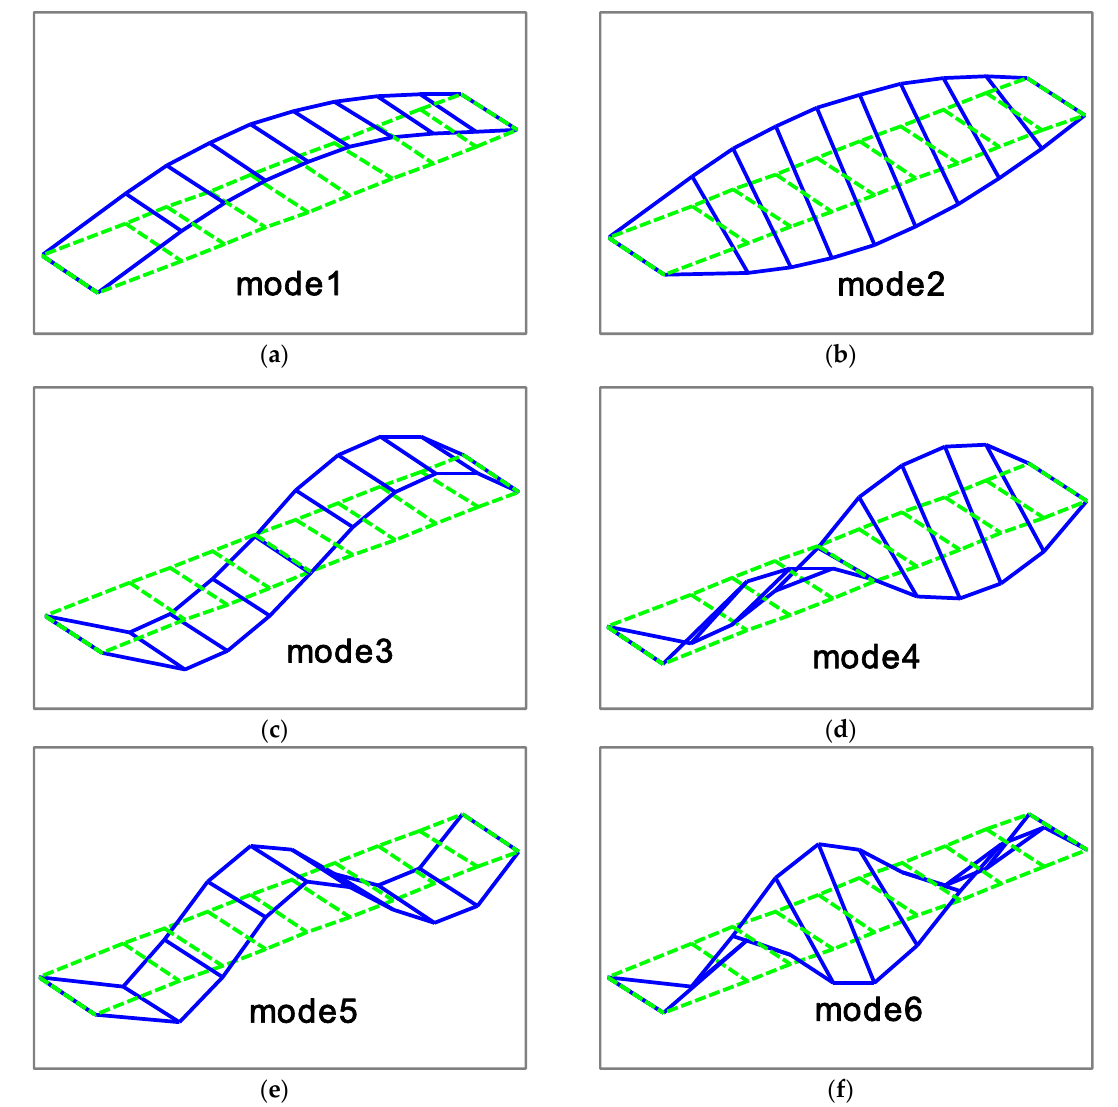
Figure 3. First six mode shapes: ( a ) Mode 1 (74.91 Hz); ( b ) Mode 2 (83.67 Hz); ( c ) Mode 3 (221.13 Hz); ( d ) Mode 4 (240.72 Hz); ( e ) Mode 5 (312.06 Hz); ( f ) Mode 6 (370.63 Hz).